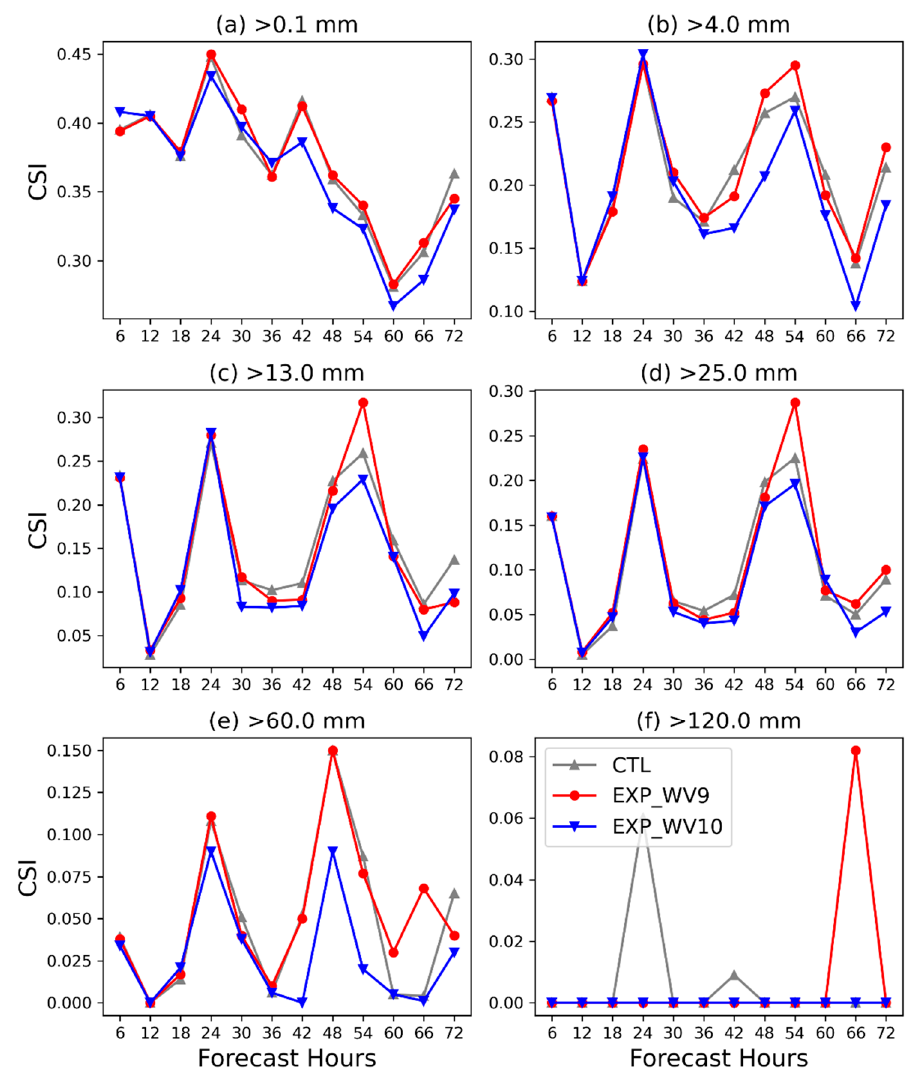
Figure 17. The CSI variations of 6 h accumulated precipitation in the 0–72 h forecasts of the CTL (grey), EXP_WV9 (red), and EXP_ WV10 (blue) for different rainfall thresholds with the initial time